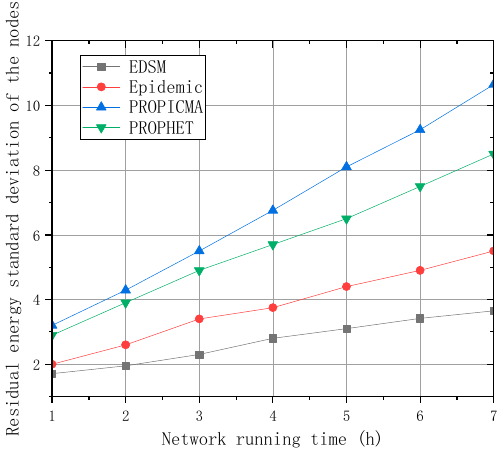
Figure 2. Standard deviation of node residual energy under different network running time.